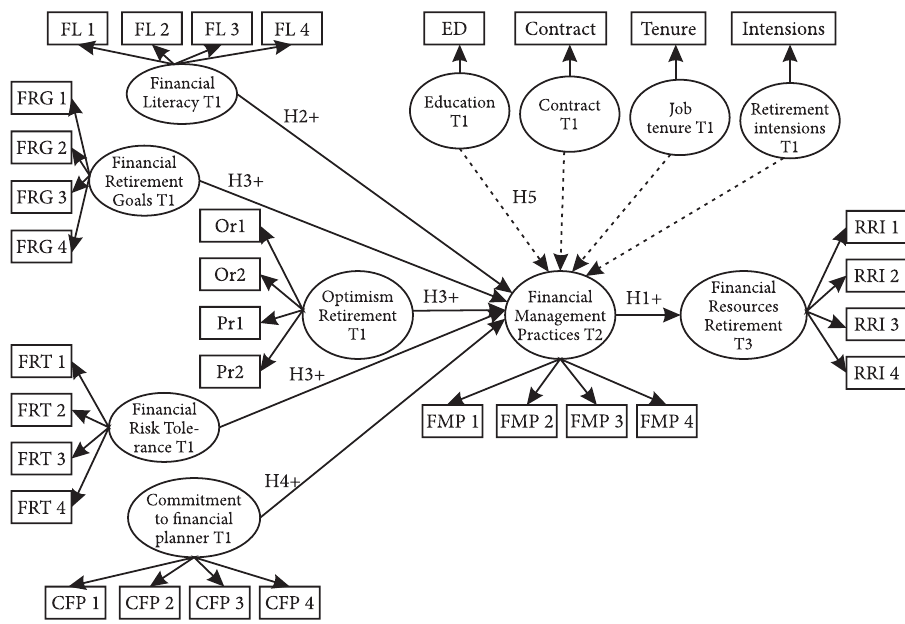
Figure 1. Hypothesized model (source: own developed by